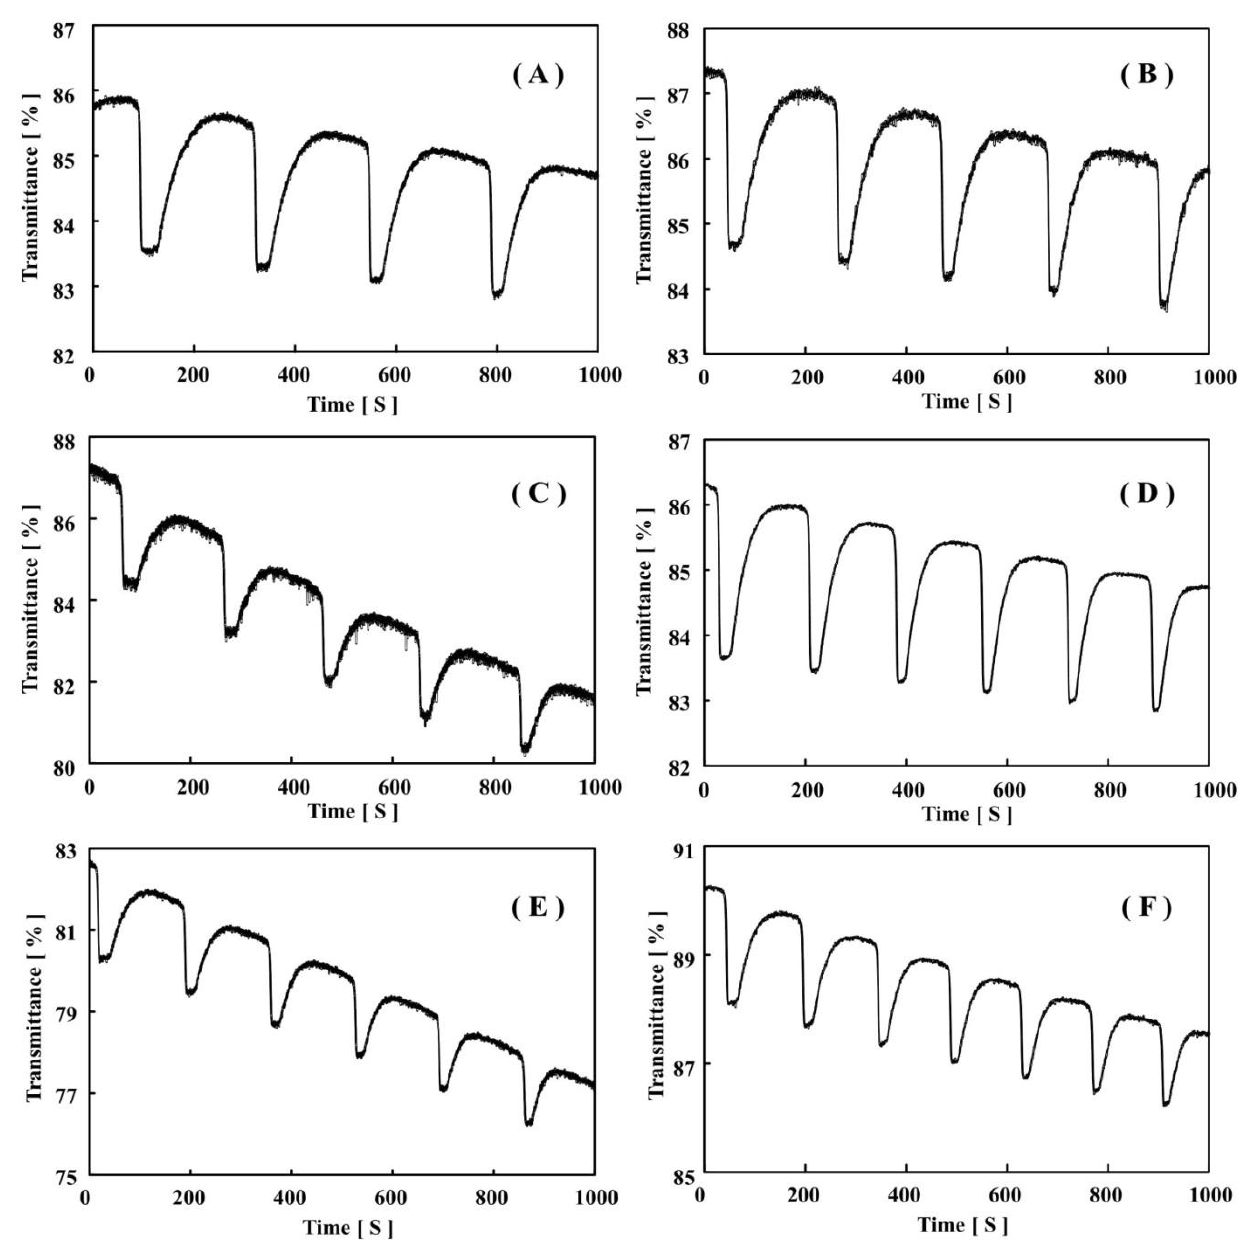
Figure 3. Oscillating profiles of transmittance at 14 °C for 0.5 wt% poly(VP- co -Ru(bpy) solution in the fixed nitric acid and sodium bromate conditions ([HNO [NaBrO ] = 0.3 M): ( A ) [MA] = 0.04 M, ( B ) [MA] = 0.05 M, ( C ) [MA] = 0.06 3